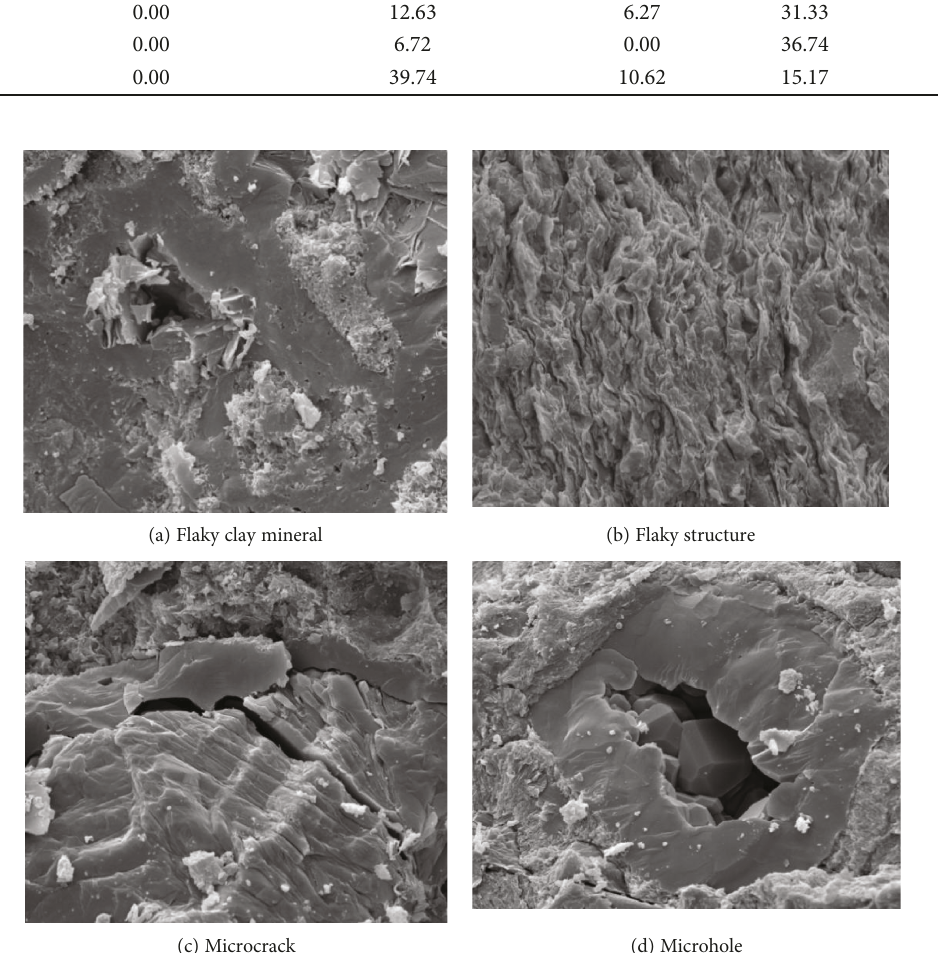
Figure 1: SEM images of the shale core in well